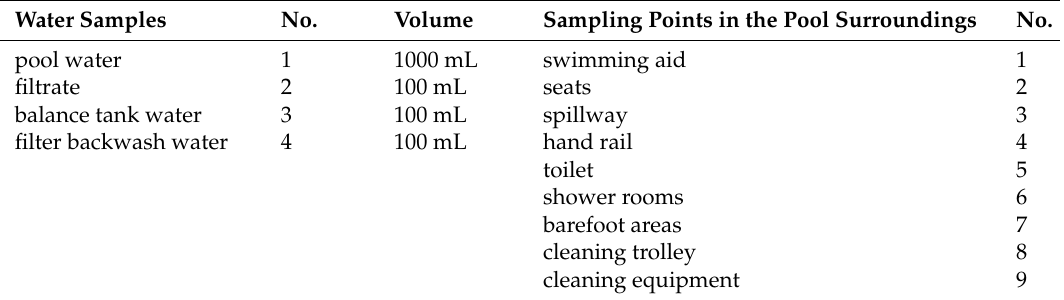
Table 1. Sampling sites of water samples (left column) and surrounding surfaces (right column). Water